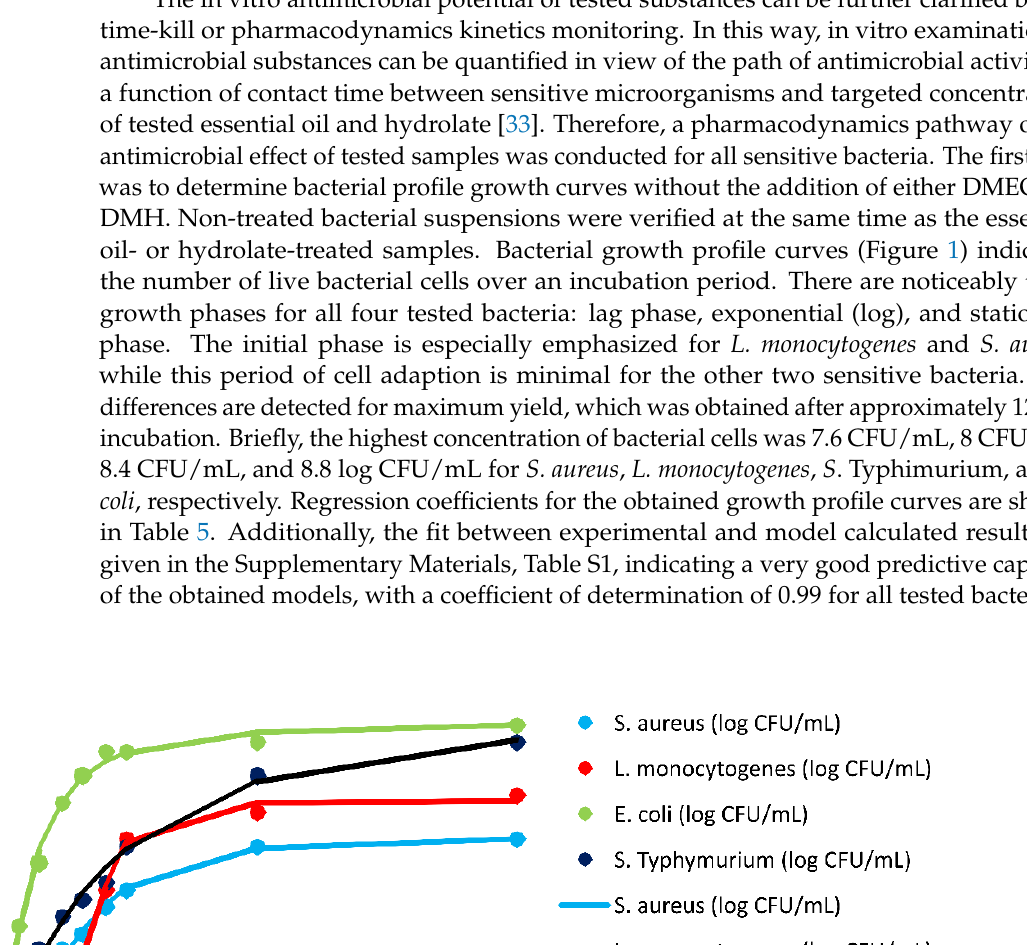
Table 5. Regression coefficients for bacterial growth kinetics (control samples).